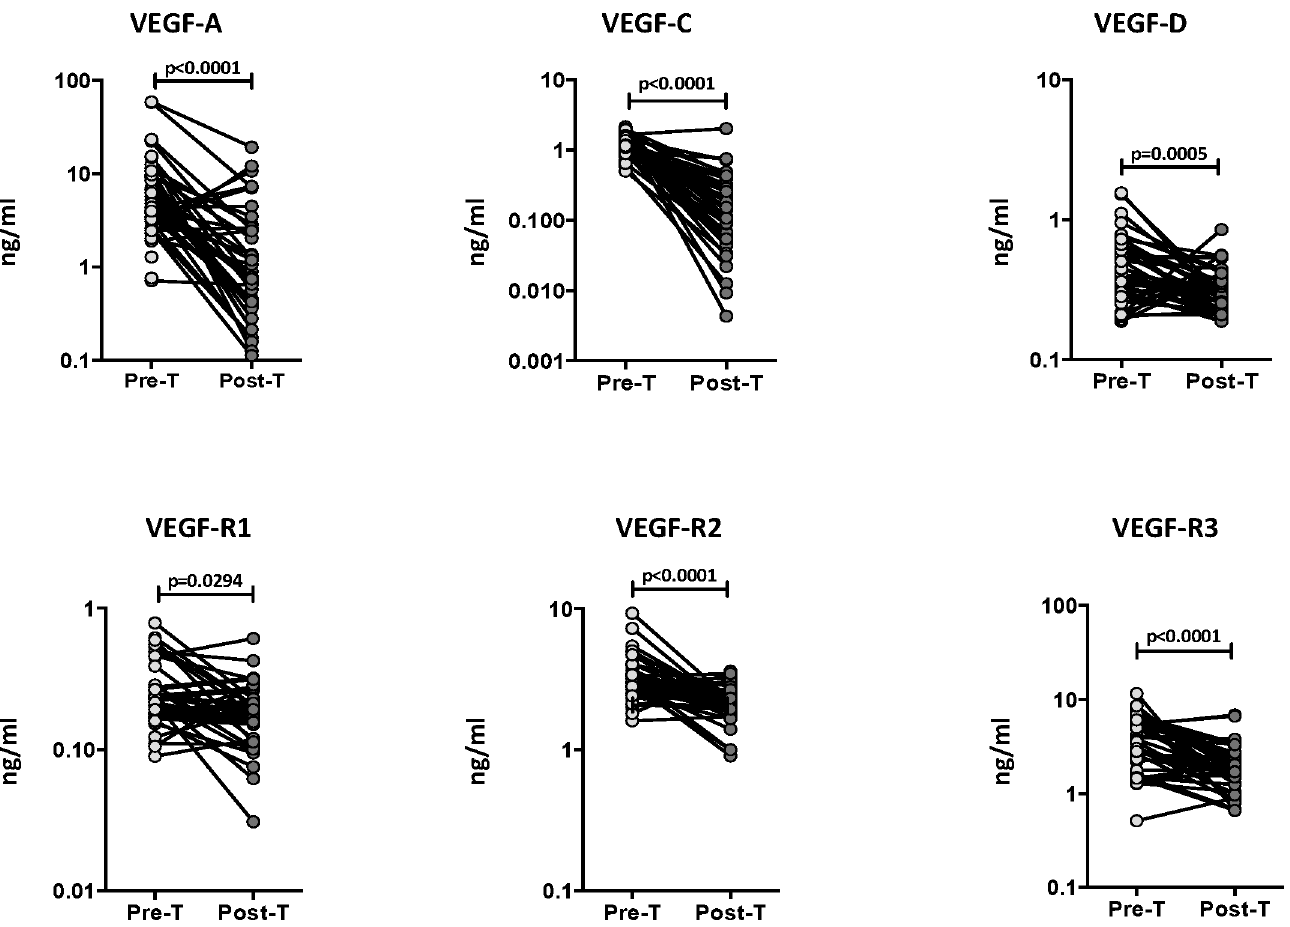
Fig 5. Diminished systemic levels of angiogenic factors following anti-tuberculous treatment in PTB individuals. The plasma levels of VEGF-A, C and D, VEGF-R1, R2 and R3 were measured in PTB individuals before (pre-T) and after (post-T) standard anti-tuberculous chemotherapy. The data are represented as line graphs with each line representing a single individual. P values were calculated using the Wilcoxon signed rank test.